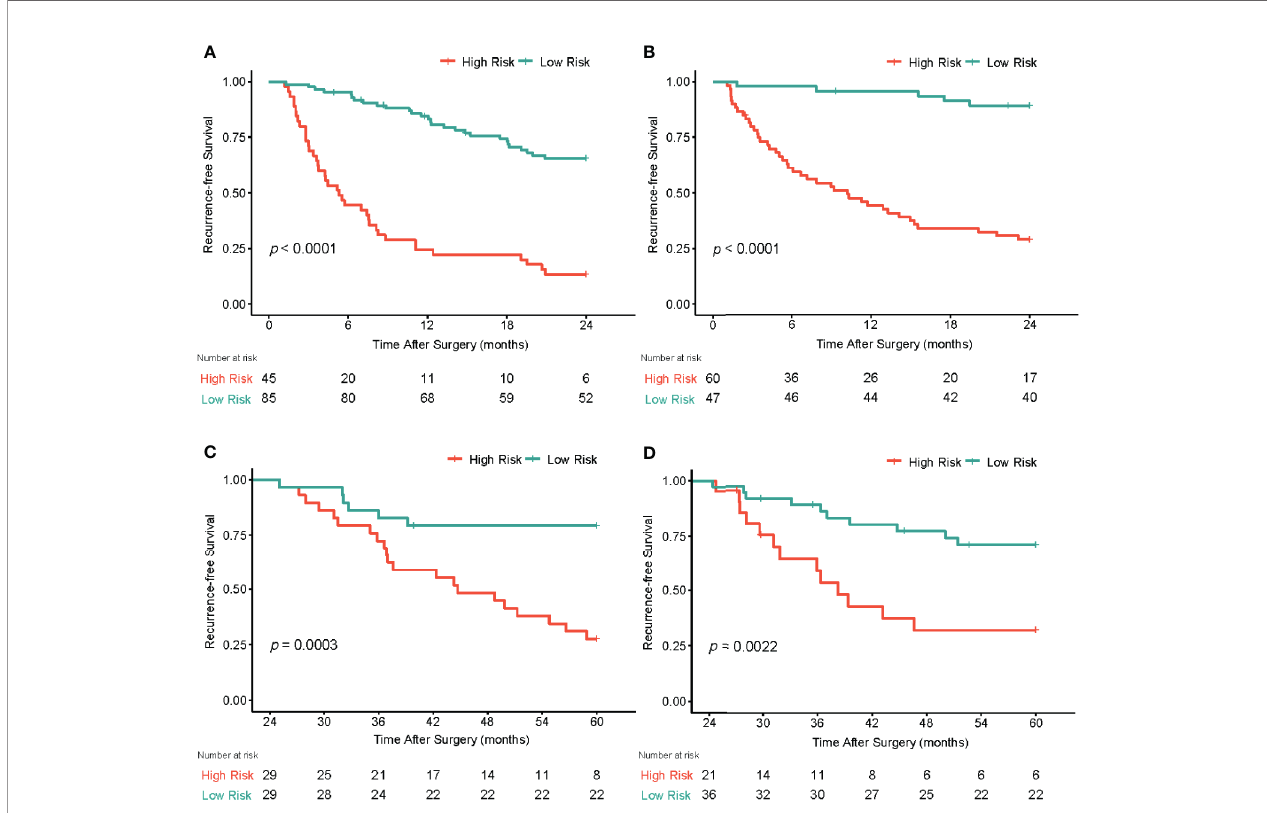
FIGURE 5 | Graphs show recurrence-free survival (RFS) of patients. In early postoperative periods (<2 years), patients were strati fi ed into low-risk and high-risk subgroups by the optimal cut-point according to the radiomics nomogram, the survival curves of the low-risk and high-risk groups were signi fi cantly different in the primary (A) and validation (B) cohorts. In late postoperative periods (>2 years), patients were successfully strati fi ed into low-risk and high-risk groups according to the spleen radiomics signature in the primary (C) and validation (D)